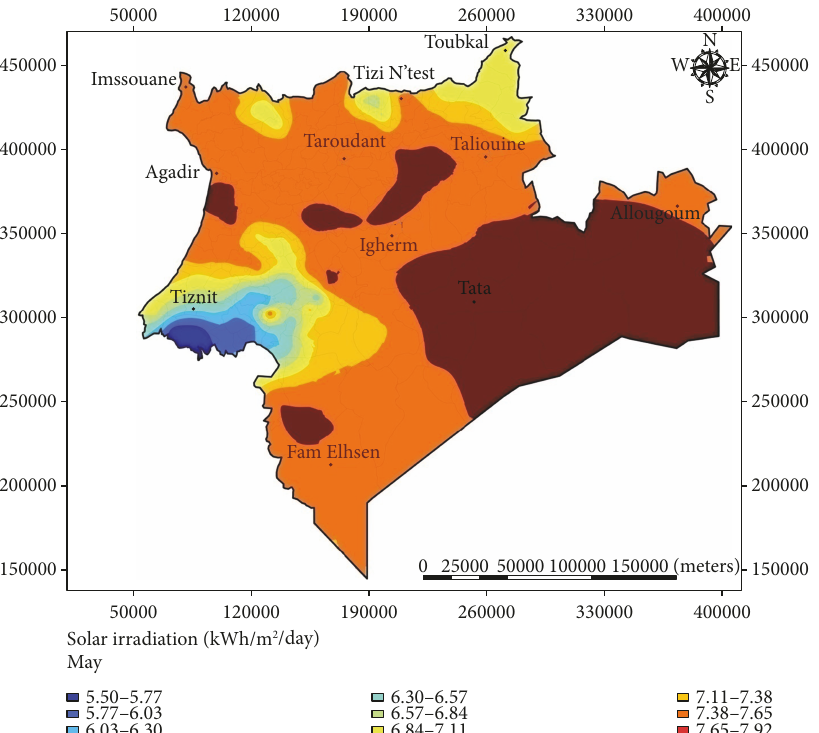
Figure 13: Solar energy potential map of the Souss-Massa area for the month of May as estimated by the ANN and designed with the Kriging interpolation technique.